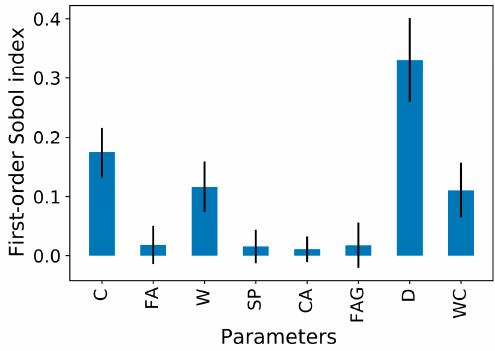
Figure 11. Sensitivity indices—first-order index.